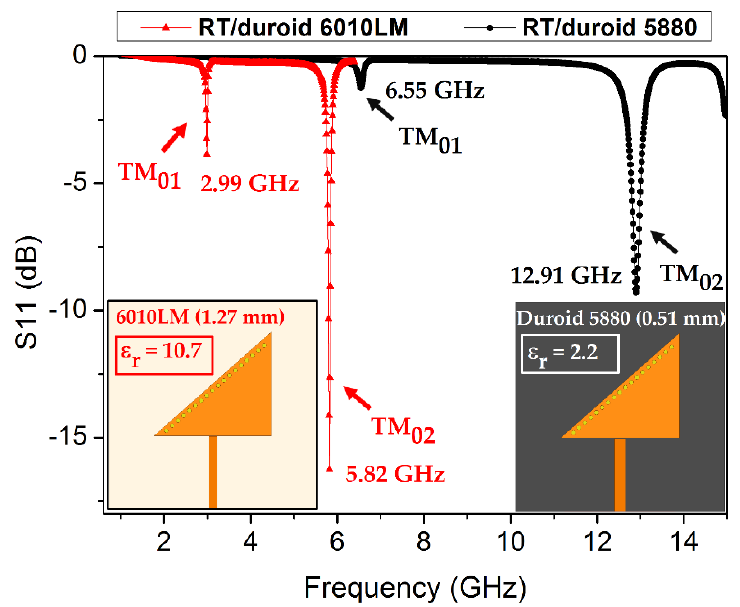
Figure 1. TM 02 -mode QMSIW resonator realized on two substrates having significantly different dielectric constants; the corresponding return loss (S11) and resonance frequencies are shown. RT/duroid 6010LM (ε r = 10.7) exhibits a significant downshift in the resonance frequency, which ensures a compact design compared with the design realized on RT/duroid 5880 (ε r = 2.2). The TM 02 -mode in each case is verified after analyzing the E-field magnitude distribution, which is not shown here for brevity.